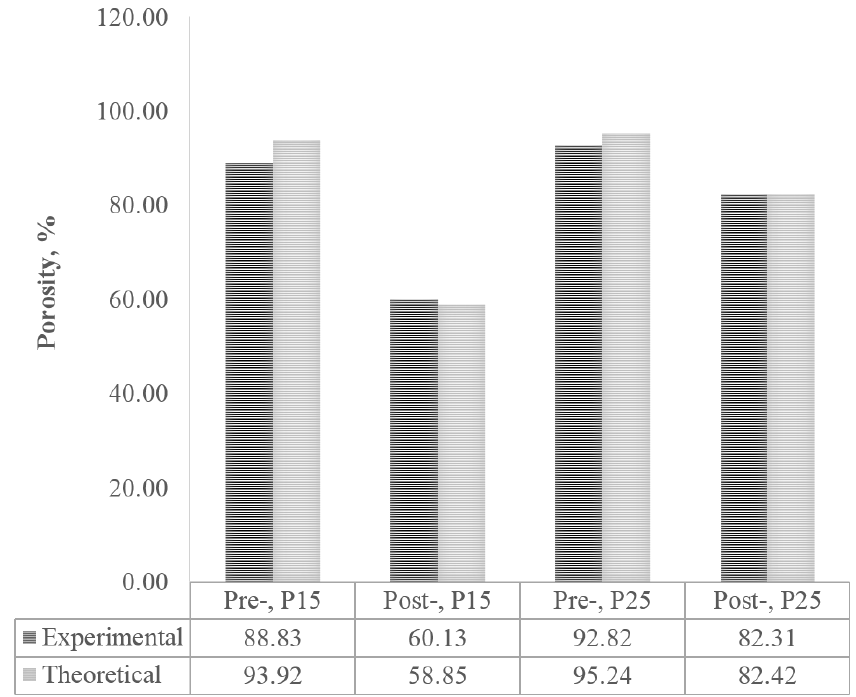
Figure 5. Experimental and theoretical measurement of porosity percentage of porous Cu interlayer.